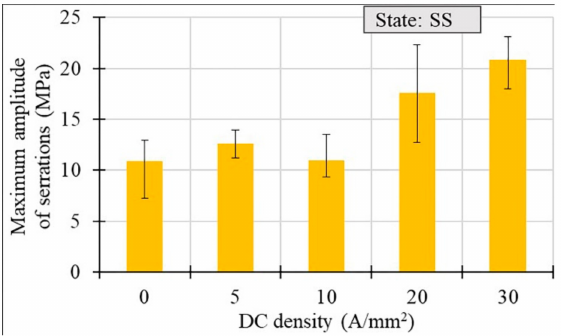
Figure 9. Maximum amplitude of serrations vs. DC density for the